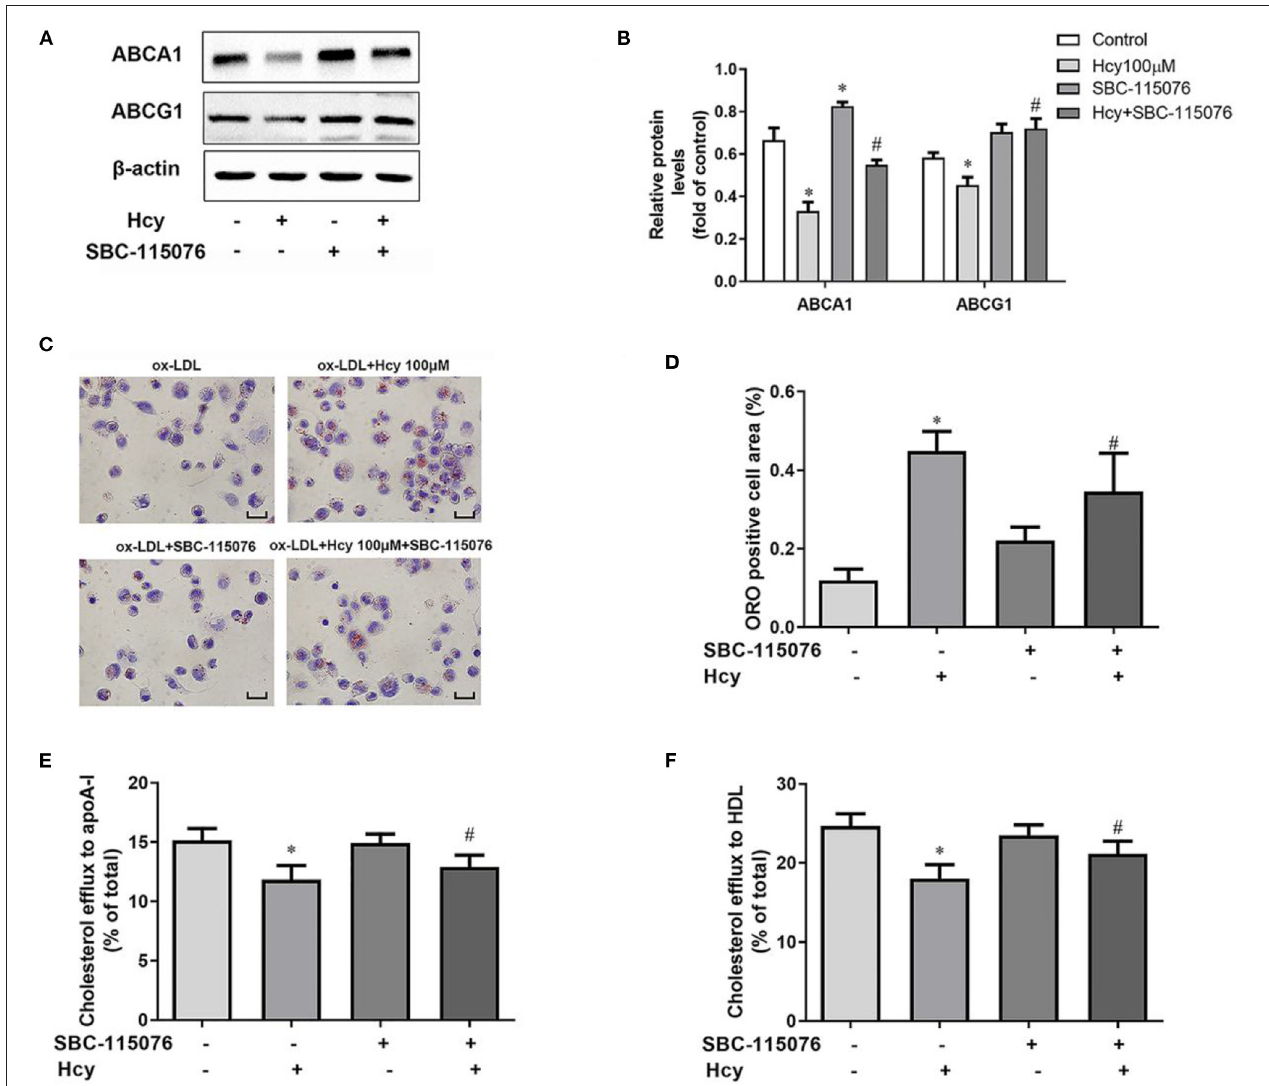
FIGURE 3 | SBC-115076 reversed the downregulation of ABCA1 and ABCG1, lipid accumulation and inhibition of cholesterol efflux induced by Hcy. THP-1 macrophages were treated with 100 µ mol/L Hcy and 20 µ mol/L SBC-115076 for 24h. The protein expressions of ABCA1 and ABCG1 were determined by western blot analysis (A,B) . Oil-red O (ORO) staining was used to assess lipid accumulation (C,D) . Cholesterol efflux to apoA-I or HDL from THP-1 macrophage-derived foam cells was assessed (E,F) . Data represent mean ± standard error of the mean (SEM). Each experiment was performed three times. * p < 0.05 vs. the control group (Hcy 0 µ mol/L, which refers to incubation with PBS only). # p < 0.05 vs. Hcy group (Hcy 100 µ mol/L). Scale bar = 25 µ m. Hcy,